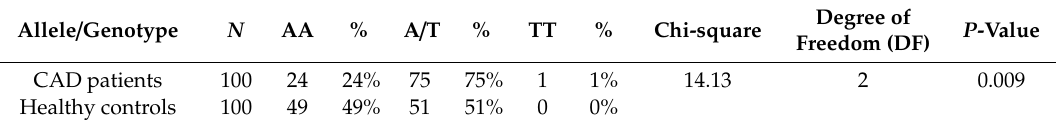
Table 3. The rs2274907 A > T genotype distribution in CAD cases and